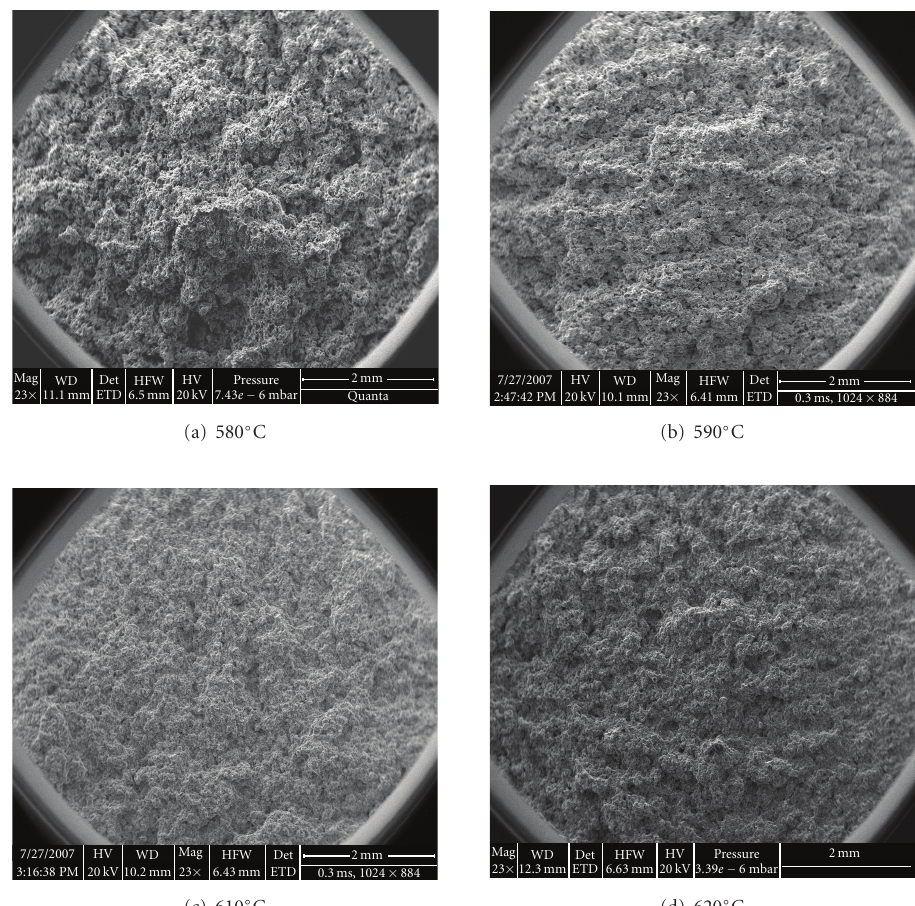
Figure 3: Fracture surface of alloy EA431 after sintering at di ff erent temperatures.